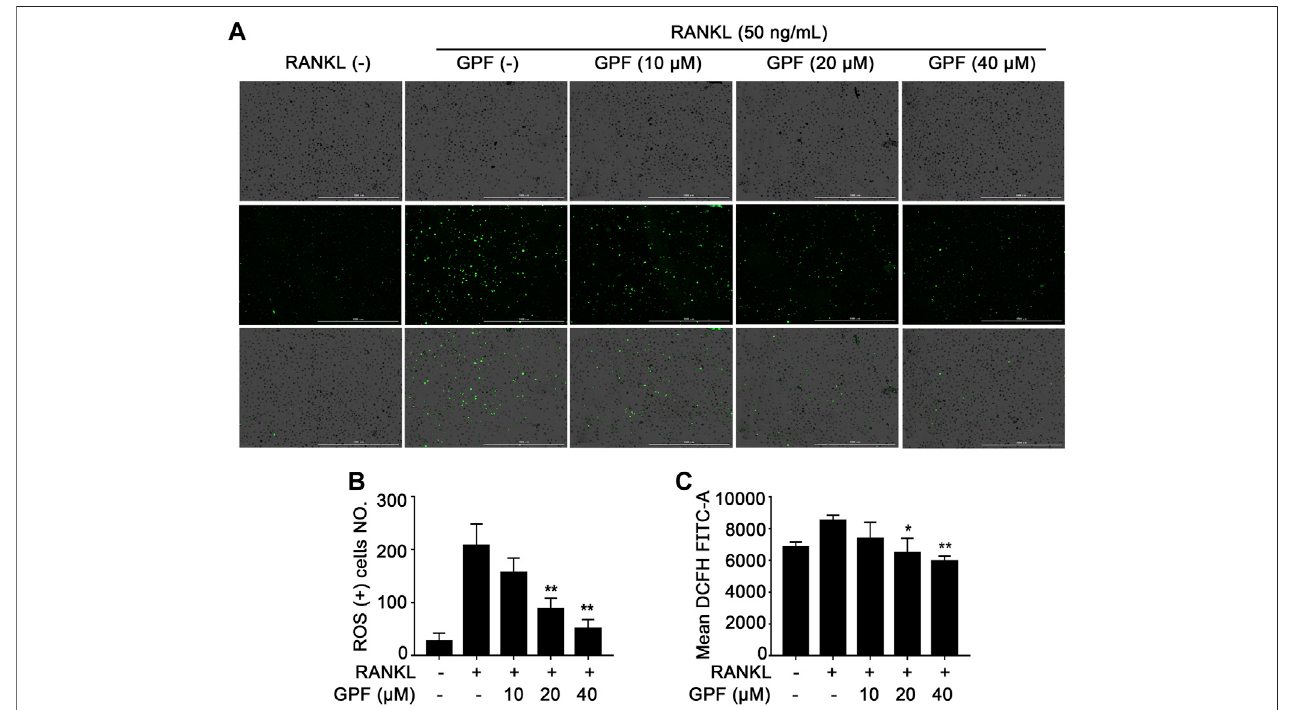
FIGURE3| GPFattenuatesRANKL-inducedROSgeneration invitro . (A) RepresentativeimagesofROSproductioninducedbyRANKLinBMMswhenpre-treated with or without GPF. (B) The quanti fi cation of ROS production was calculated ( n (cid:2) 3). (C) Mean DCFH FITC-A induced by RANKL in BMMs when pre-treated with or without GPF. All bar graphs are presented as mean ± SD. * p < 0.05, ** p < 0.01 compared with control group (without GPF treatment). One-way ANOVA. Scale bar (cid:2) 1000 µm.